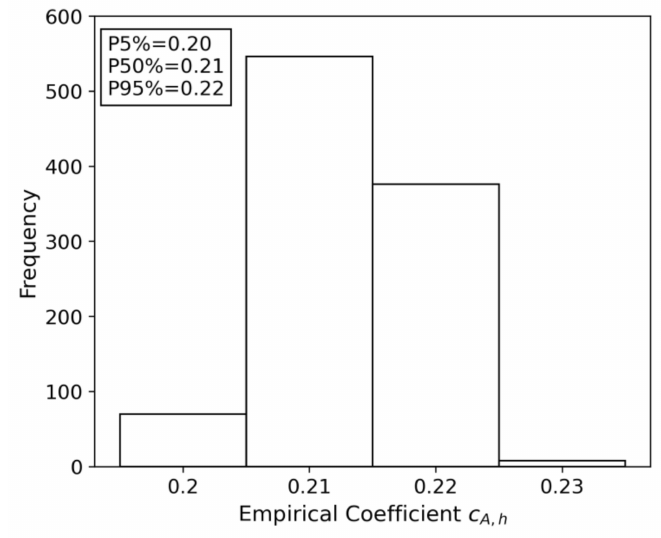
Figure 11. Histogram of the empirical coefficient, c A , h , obtained from the bootstrap resampling. Since the OLT and the OFV correspond to the same wave overtopping, the 50% percentile of roughness factor, γ f , obtained from the previous section was used together with the 50% percentile of the empirical coefficient, c A , h , to estimate the OLT. Figure 12 shows the measured and estimated OLTs using c A , h = 0.21 and γ f = 0.35. The goodness of fit for the estimation was rRMSE = 0.393 and R 2 = 0.348, which was an improvement compared with the estimation using the empirical coefficient and roughness factor available in the literature.